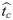
Quantile-Violin plots of tc^ for the seven values of tend.(A) dt = 500 trading days. (B) dt = 750 trading days. (C) dt = 1000 trading days. Each panel shows the results of the analysis for the following set of tend = 1987.03.19, 1987.04.30, 1987.06.25, 1987.08.06, 1987.10.15, 1988.02.11 and 1988.04.21. tc^ is determined by quantile regression of the log-price of the S&P 500 1987 bubble with Formula (4) with the search space: m ∈ [0, 2], ω ∈ [1, 50] and tc ∈ [tend − 0.20dt, tend + 0.20dt]. For each tend, the right side of the Quantile-Violin plot gives the rotated kernel density function of tc^ over the set of 99 quantiles, as well as the descriptive statistics, such as the median (red line), the upper quartile (blue line), the mean (black line) and the lower quartile (brilliant blue line). These values can be read on the scale along the main vertical axis tc axis. The left side of the Quantile-Violin gives values of q for each tc^ contributing to the distribution on the right side, with q = 0 on the axis and q = 1 corresponding to the maximum extension to the left. The red dashed horizontal and vertical lines represent the real critical date Tc = 1987.10.19.